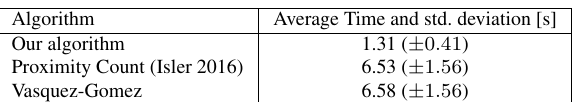
Figure 12. Real world